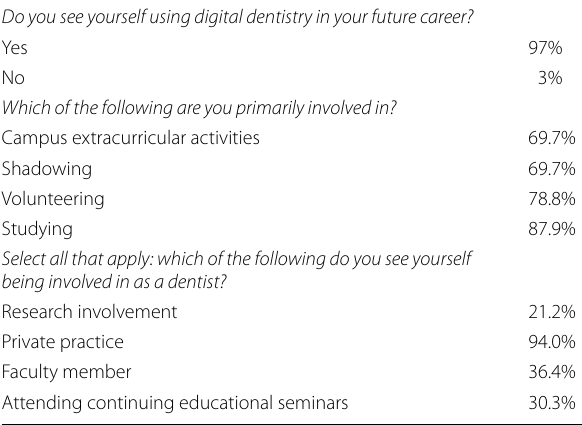
Table 2 Students awareness for career vision